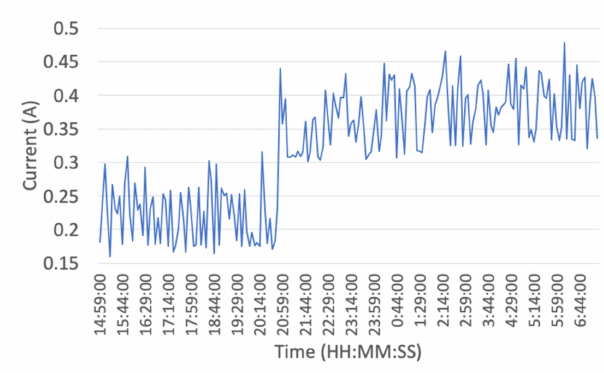
Figure 8. Power consumption of camera